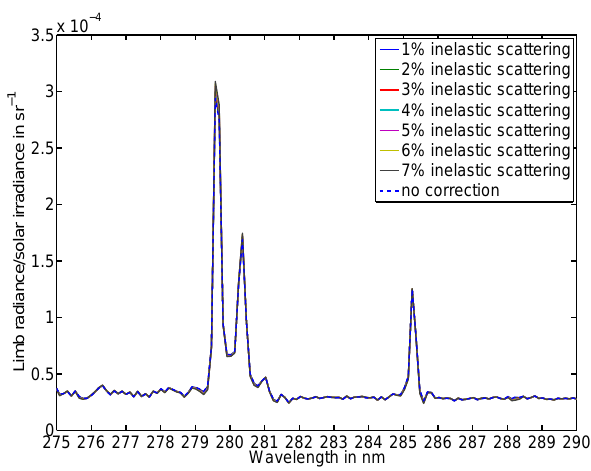
Fig. 8. Vertical slant column emission (SCE) profile with different percentages of inelastic scattering in the Ring effect correction. The difference between the corrected and uncorrected profile increases with decreasing tangent altitude below 90km. Note that the SCE of Mg at 53.5km is still in the order of 50% of the SCE at 90km for typical recalculations of the forward model from retrieval